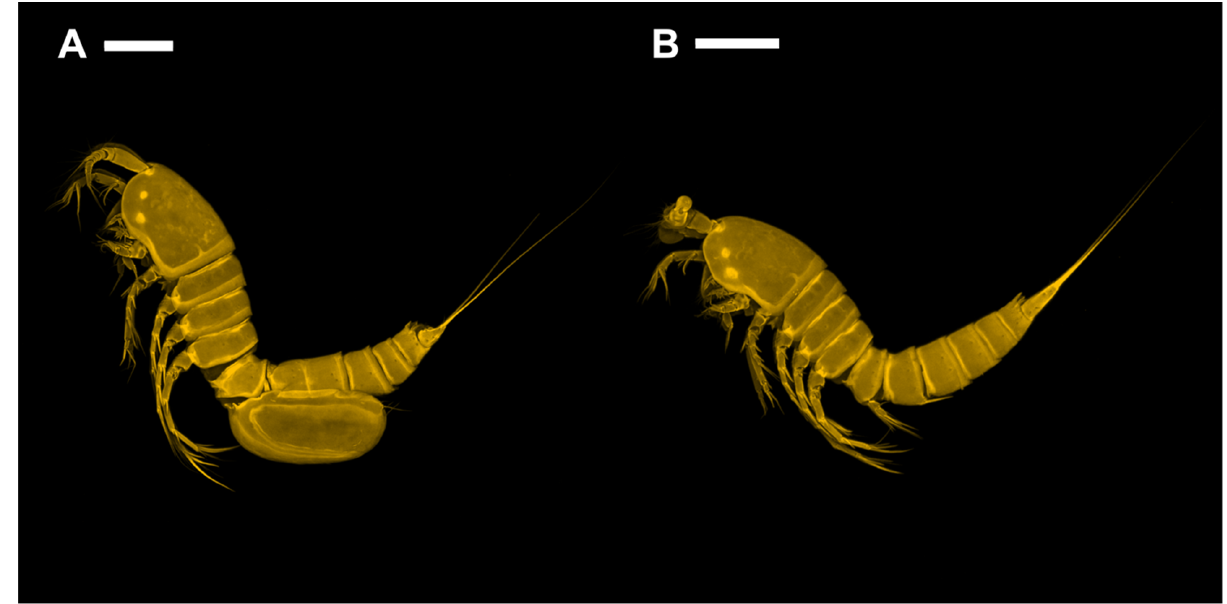
Figure 20. Confocal laser scanning microscopy images of Phyllopodopsyllus similis sp. nov. ( A ) female